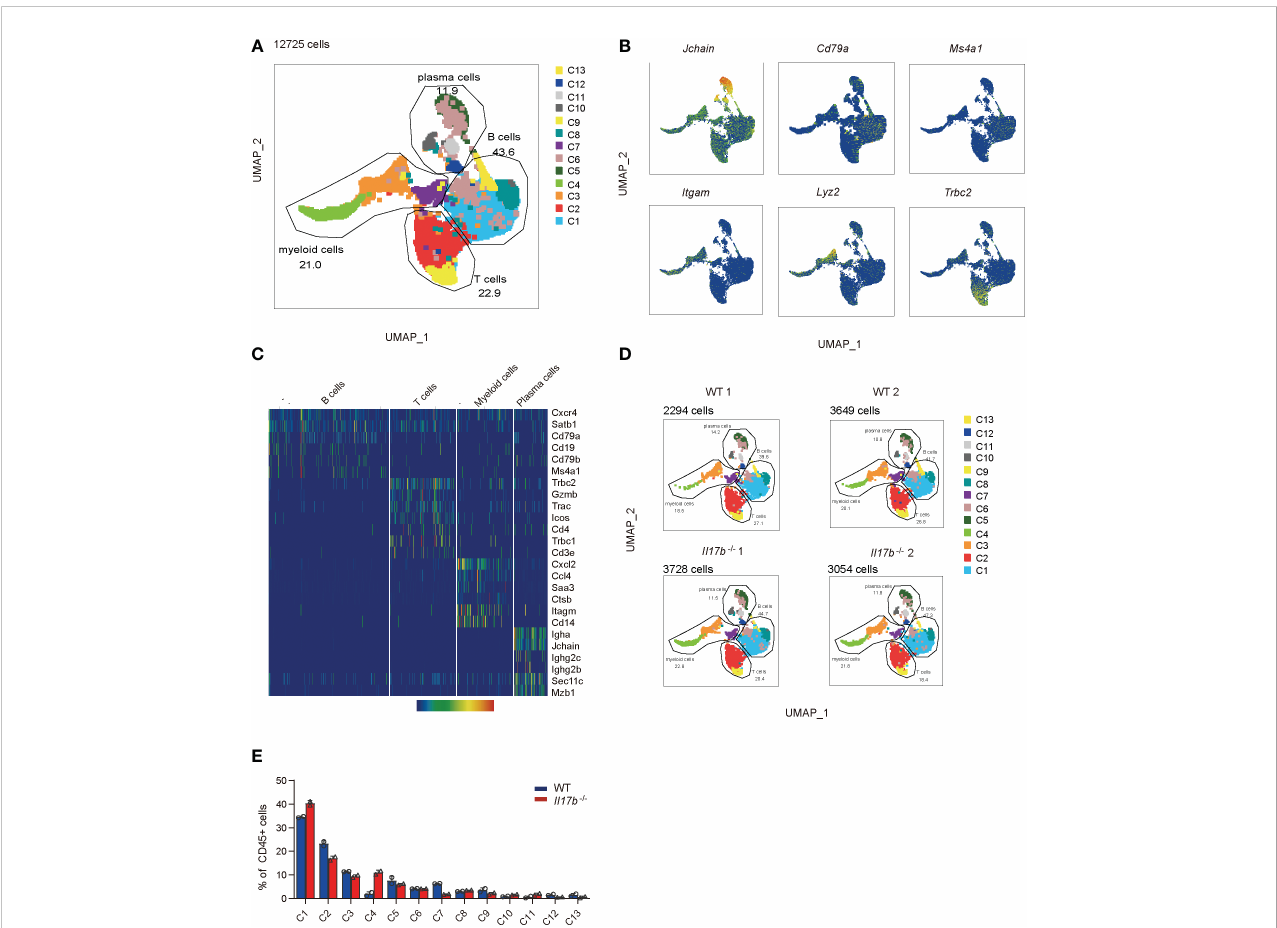
FIGURE 4 Single cell transcriptome analysis of colon lamina propria immune cells in colitis in WT and Il17b -/- mice. Two WT and two Il17b -/- mice were fed with 2.5% DSS water to induce colitis. Lamina propria CD45 + immune cells were sorted by magnetic activated cell sorting and processed for scRNAseq. (A) UMAP plot shows the clustering of 12725 immune cells, colored by cell subset and cell types. (B) UMAP plots displaying marker genes expression for cell cluster. (C) Heatmap showing speci fi c marker genes for major cell types. (D) UMAPs plots showing a comparison of the CD45 + cell clusters distribution in WT and Il17b -/- colitic mice. (E) Percentage of each cell cluster in CD45 + cells in WT and Il17b -/- colitic